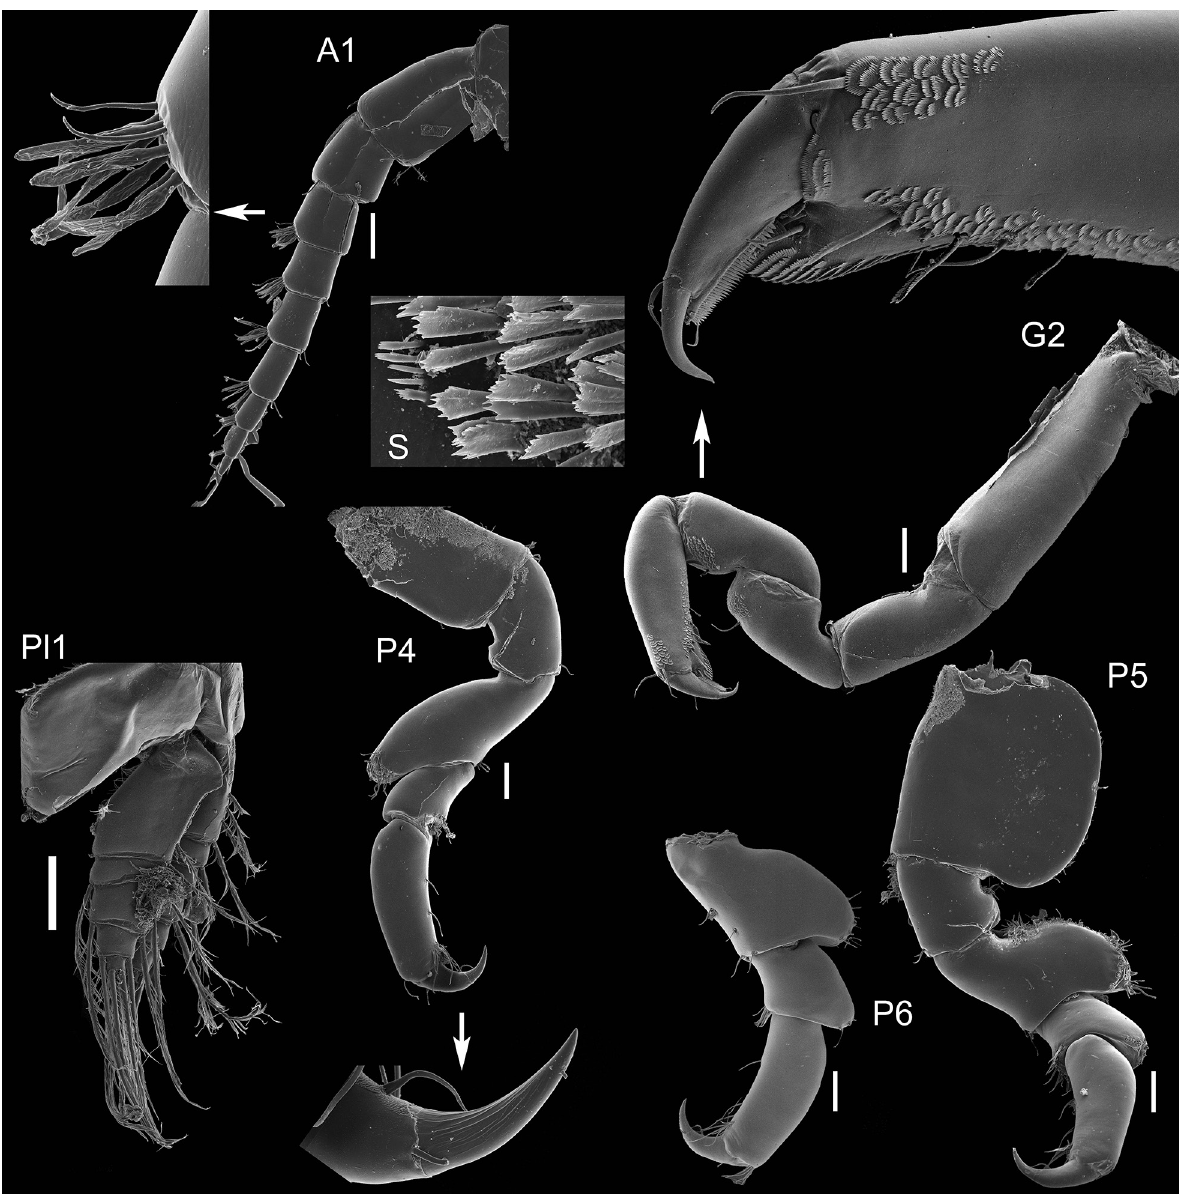
Figure 7. Bircenna thieli sp. nov. paratype SEM, gender indet. rego no. ZMH-K 45993, Bicheno, Tasmania, Australia. Scale bars: 100 µm.